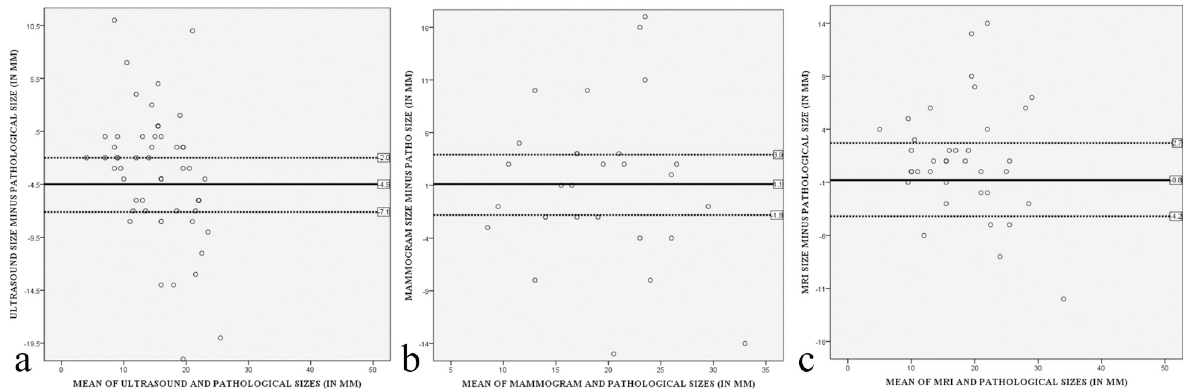
Fig 8. Bland-Altman plots of imaging (US, MMG, and MRI) and pathological size differences versus mean size differences.